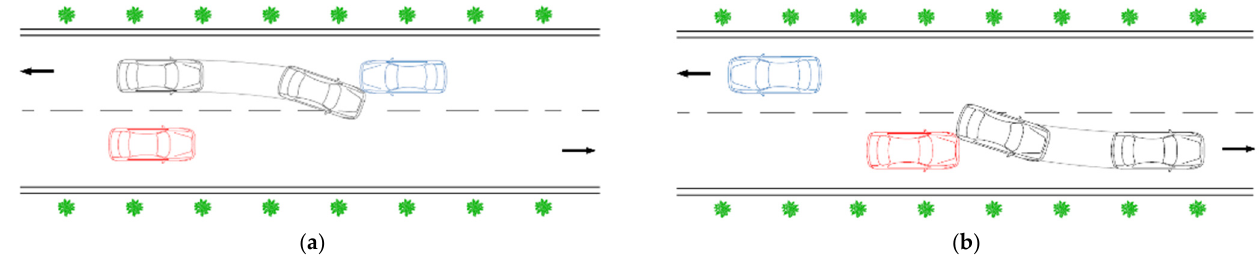
Figure 2. Collision types during the second phase of overtaking on a two-lane highway. ( a ) A collision with the opposite vehicle; ( b ) a collision with the impeding vehicle when turning back to the original lane.